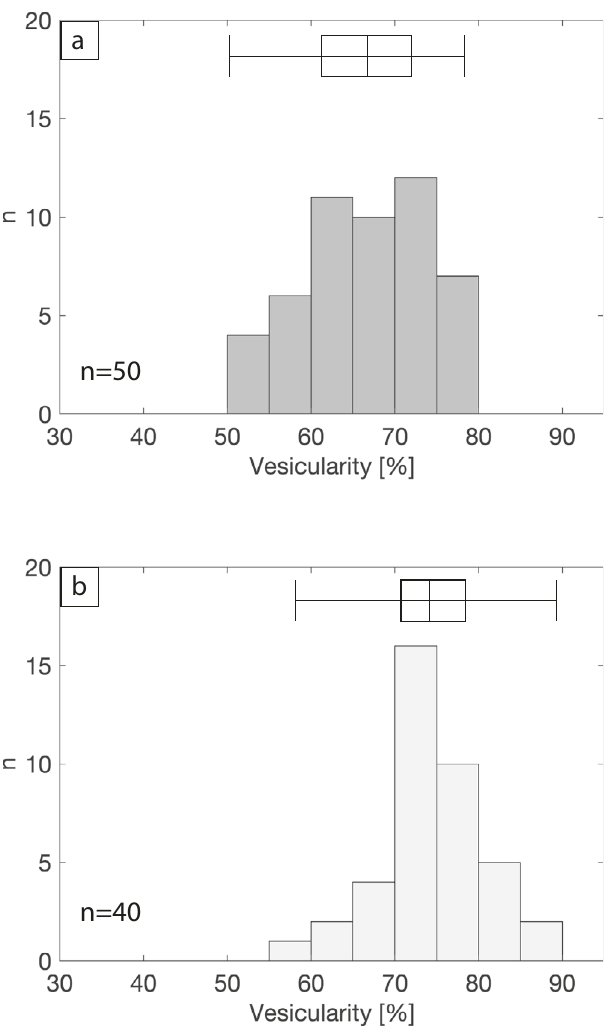
Fig. 5 Bulk vesicularity histograms. Data shown for a the proximal scoria and b the in fl ated pyroclasts. The number of samples (n) measured is reported for each dataset. The box and whisker plots display the data range (whiskers) and the fi rst quartile, median and third quartile (box). The corresponding bulk vesicularity can be found in the Supplementary Data 1 fi le.